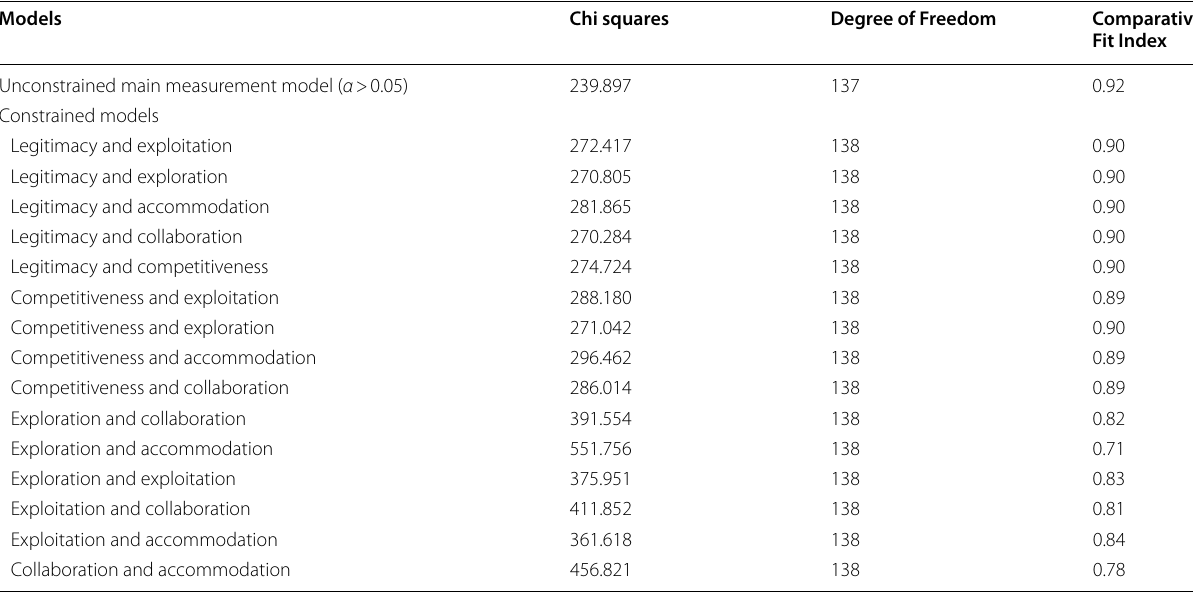
Table 7 Result of nested measurement model comparisons